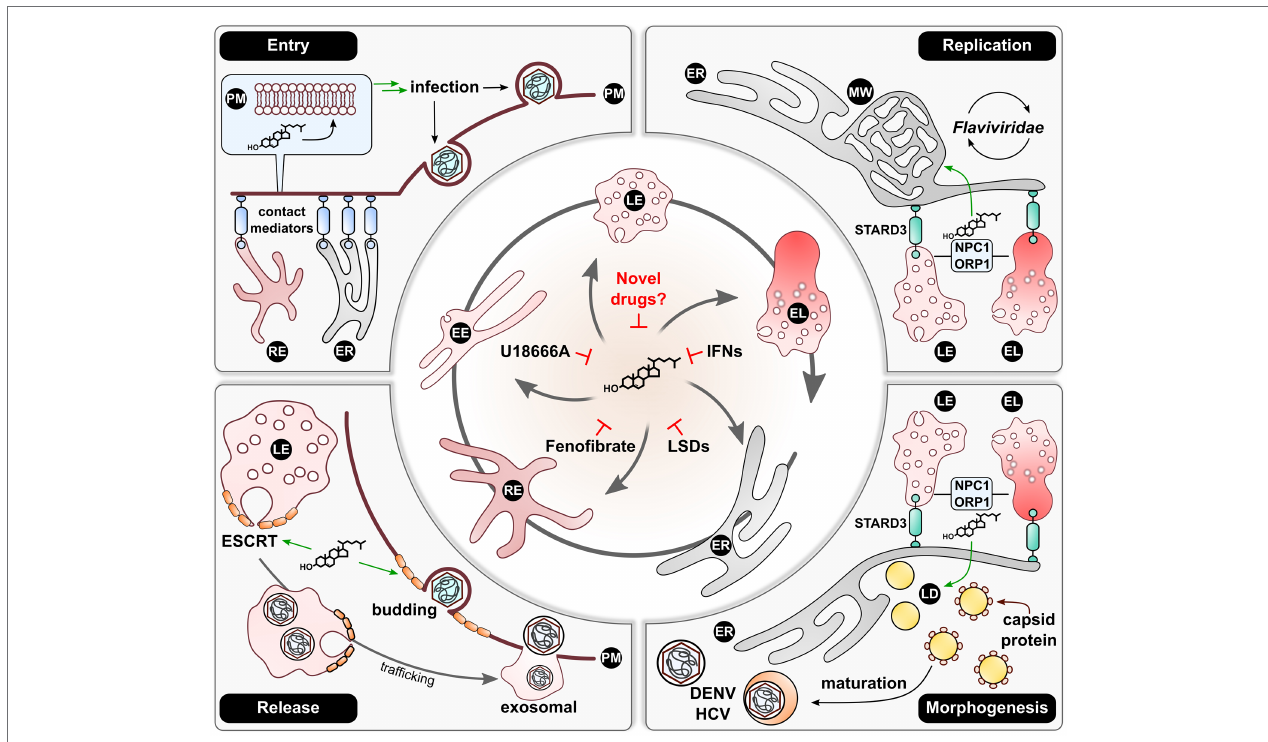
FIGURE 2 | An efficient endosomal re-distribution of cholesterol is required for sustainment of viral life cycles. The endosomal system contains central organelles maintaining cellular cholesterol distribution. Viruses thus make use of these lipid-mobilizing mechanisms to ensure sufficient spatial cholesterol supply during their life cycles. For infection or re-infection, viruses require local cholesterol accumulations at the site of PM fusion or endocytosis. These are fueled by the lipid being transported from the ER or REs, which is dependent on various adaptors establishing respective contact sites to the PM. After infection, especially members of the Flaviviridae family were described to induce a cholesterol-enriched MW or replication organelles at the ER. Lipid supply hereby is enhanced by recruiting LEs and ELs to the ER via STARD3 with subsequent cholesterol shuttling in an NPC1/ORP1-dependent manner. Similarly, well characterized for this virus family is the dependency on LDs for morphogenesis. Here, DENV and HCV rely on a comparable mechanism involving LEs and ELs for providing ER cholesterol and therefore LD morphogenesis. Lastly, various studies demonstrated that a broad spectrum of viruses is reliant on the ESCRT machinery for viral release either via the LE- mediated exosomal route or via ESCRT-mediated PM budding. The activity of ESCRT-III stands in close relationship with the local cholesterol concentration, which renders the lipid fulfilling a vital role in the production of viral progeny. Once an efficient cholesterol distribution is perturbed, viral life cycles tend to collapse. This was made use of in the past by inducing cholesterol accumulations by application of U18666A, IFNs, or Fenofibrate. Additionally, the artificial induction of LSDs yielded comparable effects. Thus, this mechanism could present as essential target to novel broad-spectrum antivirals. EE, early endosome; EL, endolysosome; ER, endoplasmic reticulum; IFNs, interferons; LD, lipid droplet; LE, late endosome; LSDs, lysosomal storage disorders; MW, membranous web; RE, recycling endosome; PM, plasma